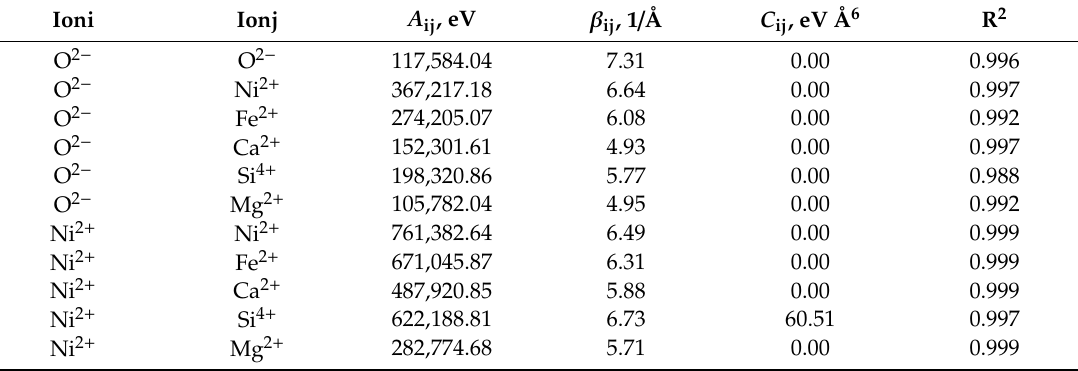
Table 2. Fitted Born-Mayer-Huggins (BMH) potential parameters of NiO-Fe x O-SiO 2 -CaO-MgO nickel slag